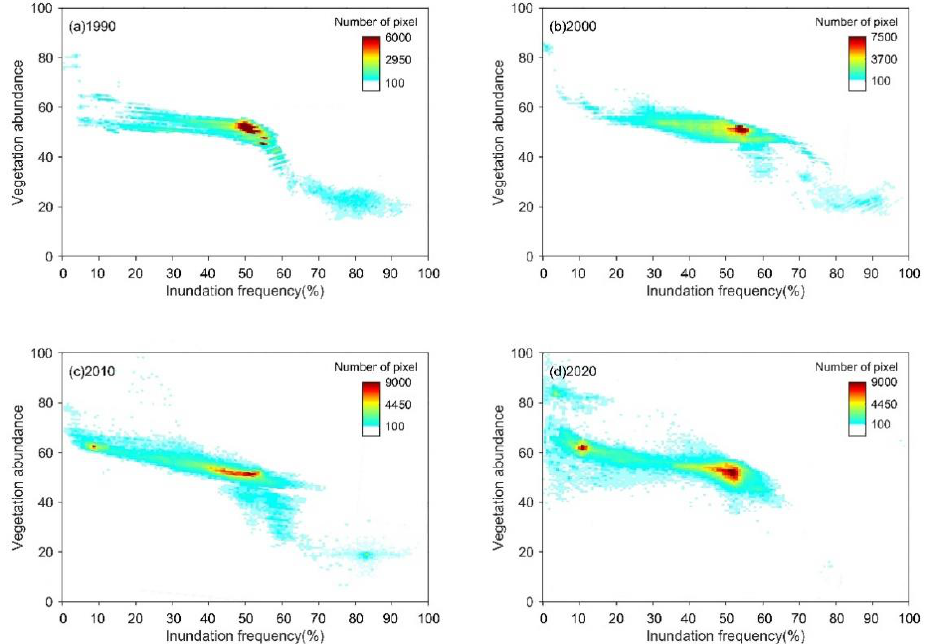
Figure 9. The inundation frequency versus vegetation abundance diagram in active estuarine area.